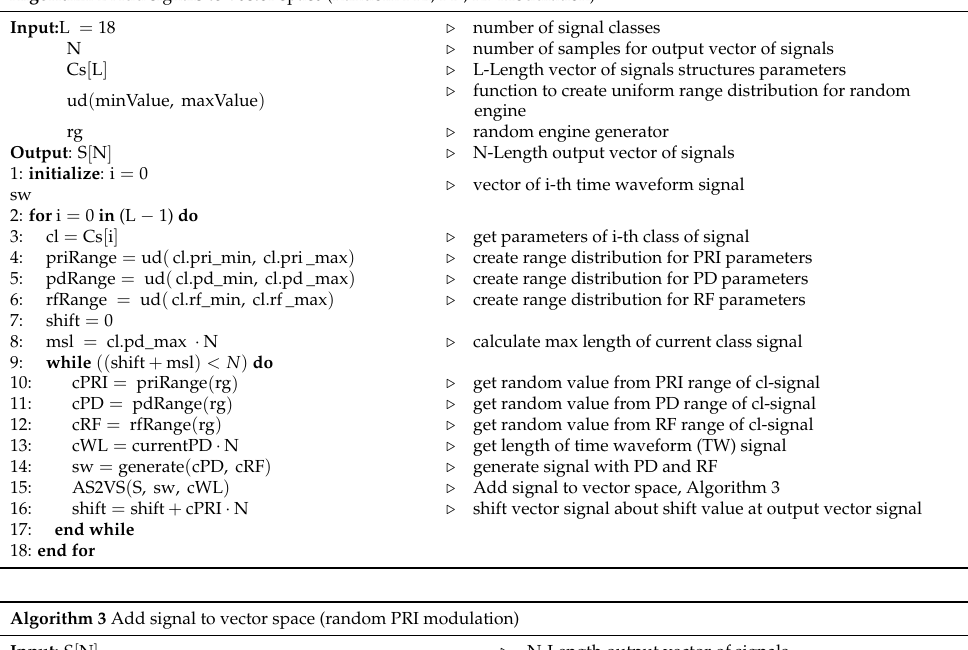
Algorithm 2 Add signals to vector space (Random PRI, PD, RF Modulation)